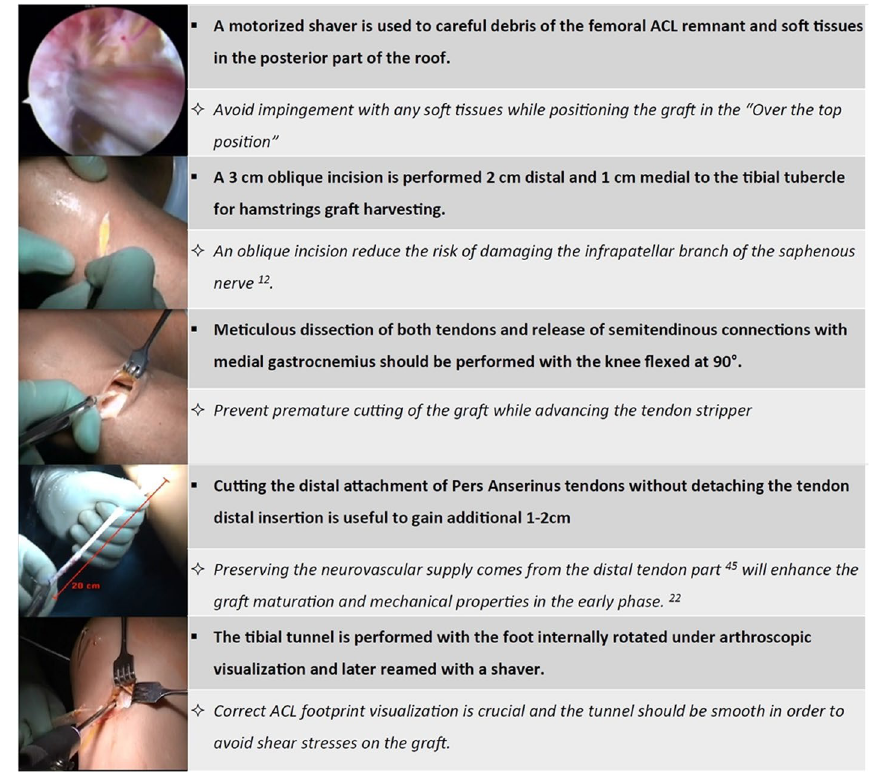
Fig. 4 Technical tips for over-the-top and lateral plasty ACL